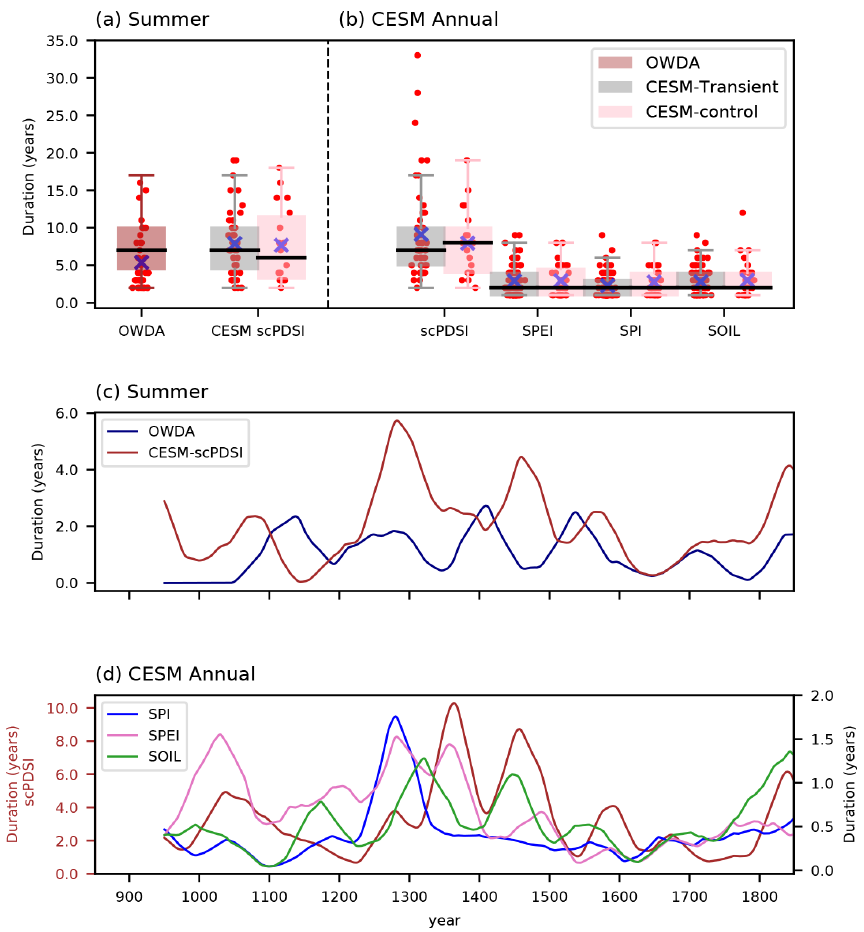
Figure 5. (a) Distribution of the duration of droughts for the summer scPDSIs from OWDA and the transient and control simulations, and for (b) the annual drought indices from the transient and control simulations in CESM. Red points indicate individual drought events, black lines on the boxes are the medians of the duration, and blue crosses are the means of duration. (c) The 100-year running means of the duration of droughts for the summer scPDSIs and (d) the annual drought indices. The indices are the self-calibrated Palmer drought index (scPDSI) from OWDA, summer scPDSI (CESM-scPDSI), annual Standardized Precipitation Index (SPI), Standardized Precipitation Evapotranspiration Index (SPEI), soil moisture anomaly (SOIL), and annual scPDSI from CESM. Note that the annual scPDSI (brown line in d ) has a separate y axis for its duration. The Mann–Whitney U tests (MW tests) are applied to the duration of droughts in (a) and (b) under the null hypothesis of an equal distribution between two time series of duration of droughts. The p value between the duration of summer scPDSI in OWDA and CESM is 0.003, which indicates that their distributions are statistically different from each other. This is also the case for all the annual indices, except between the SPEI and SOIL, with a p value of 0.87. The p values between the indices in the transient and control simulations are all statistically similar, indicating that the distribution of duration of droughts in the transient simulation is in the range of variability of the control simulation. The p values from the MW tests between the transient and control simulations are presented in Table